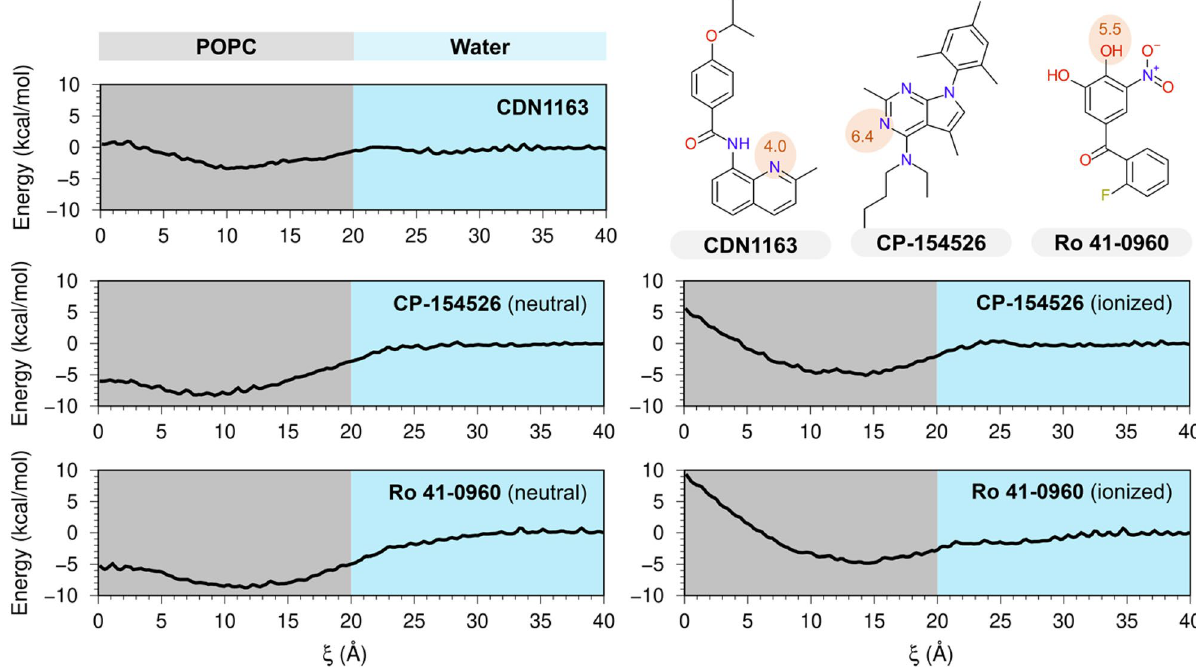
Figure 2. Bilayer-crossing free energy profiles of SERCA2a activators. Profiles are represented by the potential of the mean force (PMF) of SERCA2a activators CDN1163, CP-153526, and Ro 41-0960 along the normal z-axis of a POPC membrane; the distance along the z-axis was used here as a reaction coordinate (ξ). The chemical structures in the upper right indicate the location of titratable groups and their corresponding pKa values (red circles); based on these pKa values, Bilayer-crossing free energy profiles were calculated for either neutral or ionized states of the small molecules. The gray area illustrates only one leaflet of the lipid